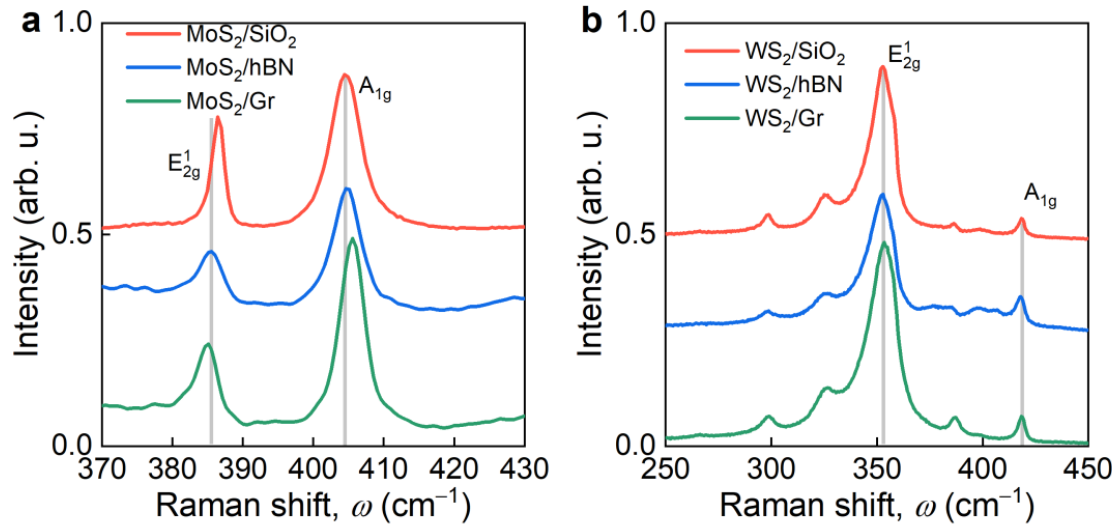
Figure 2. Raman spectra of ( a ) MoS 2 and ( b ) WS 2 in heterostructures. Grey lines are guidelines for eyes.